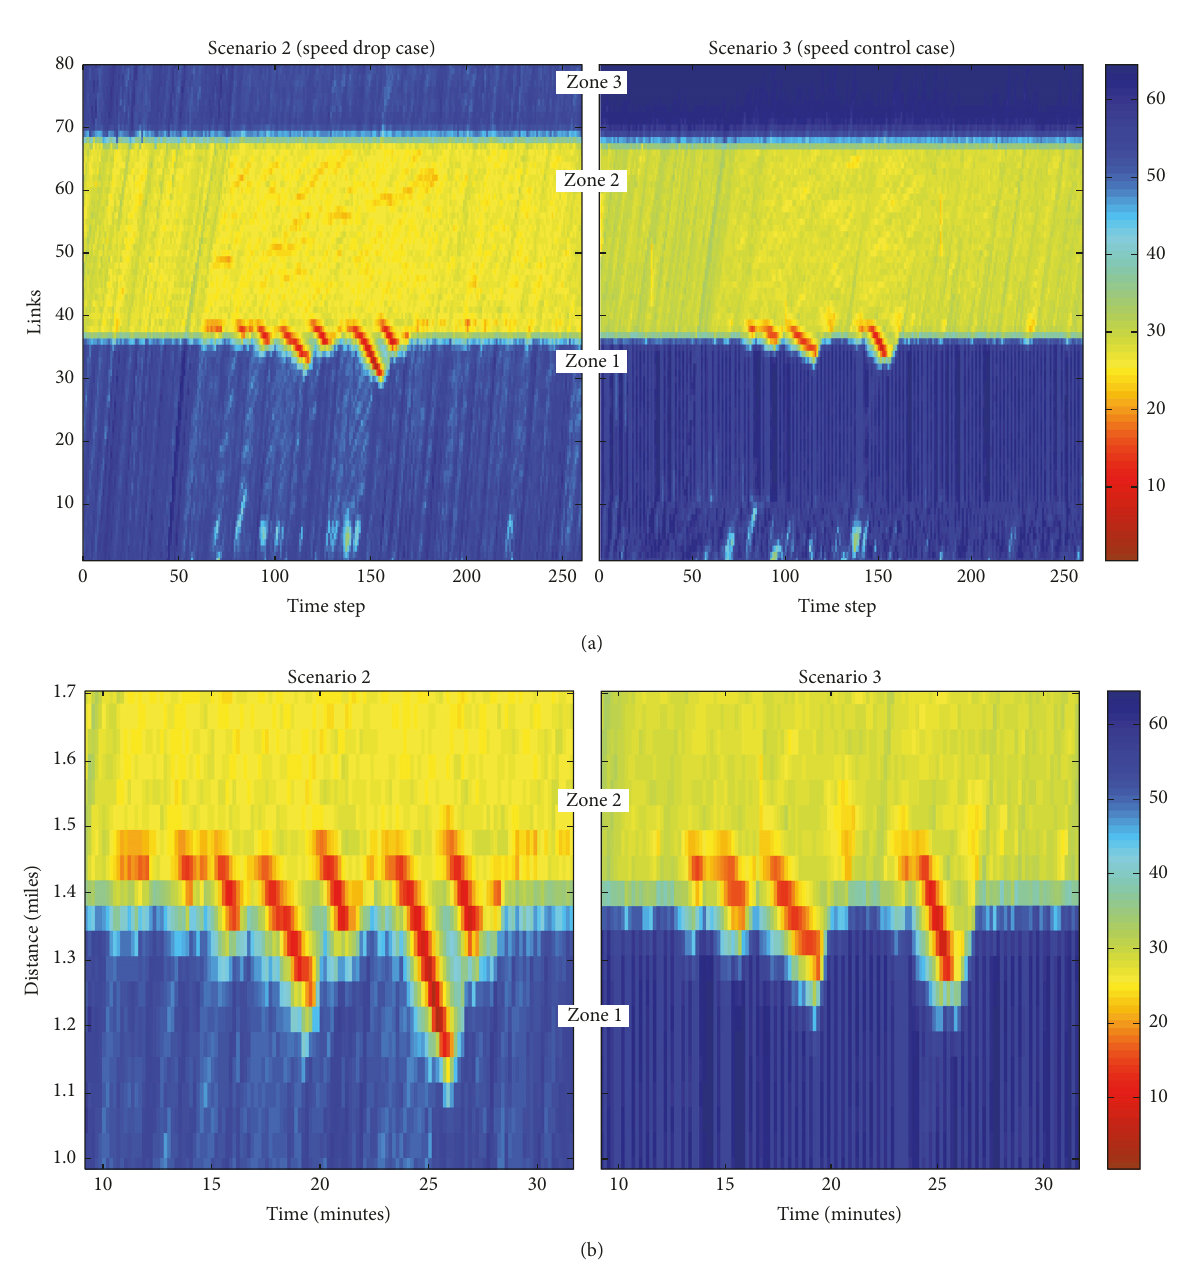
Figure 8: Speed profiles under 100% market penetration (Scenario 2 versus Scenario